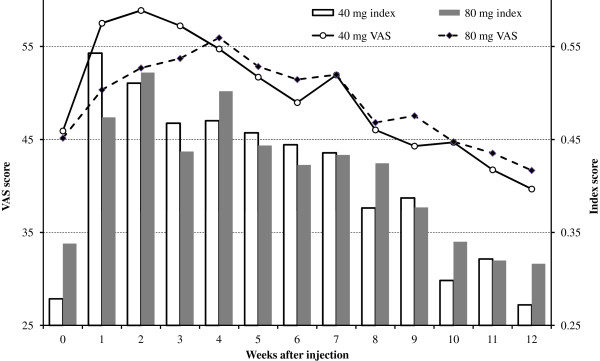
Mean EQ-5D scores.